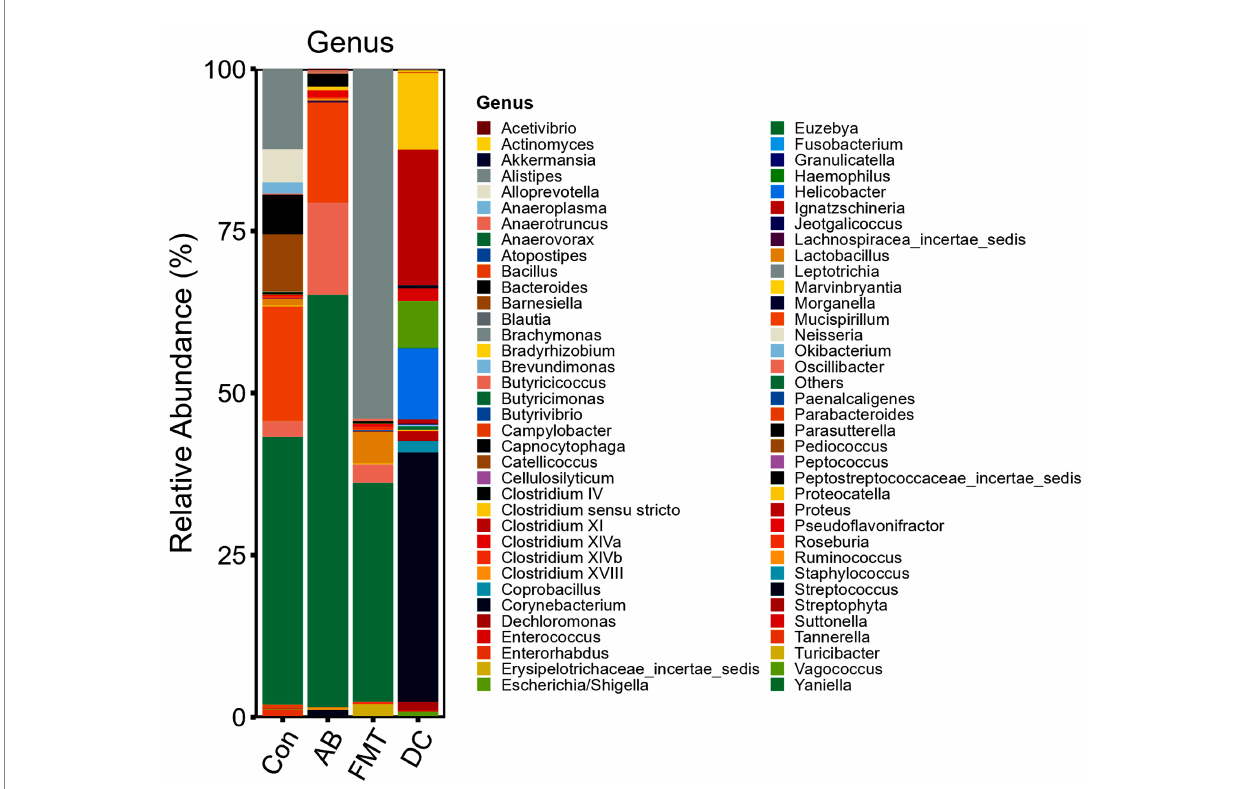
FIGURE 4 Relative abundance ratio of the intestinal microbiome at the genus level in each experimental group. Data are presented as the percentage of species, and the results were obtained using the Kruskal–Wallis test. Con, Control group; FMT, fecal microbiota transplantation group; AB, antibiotic group; DC, donor group.